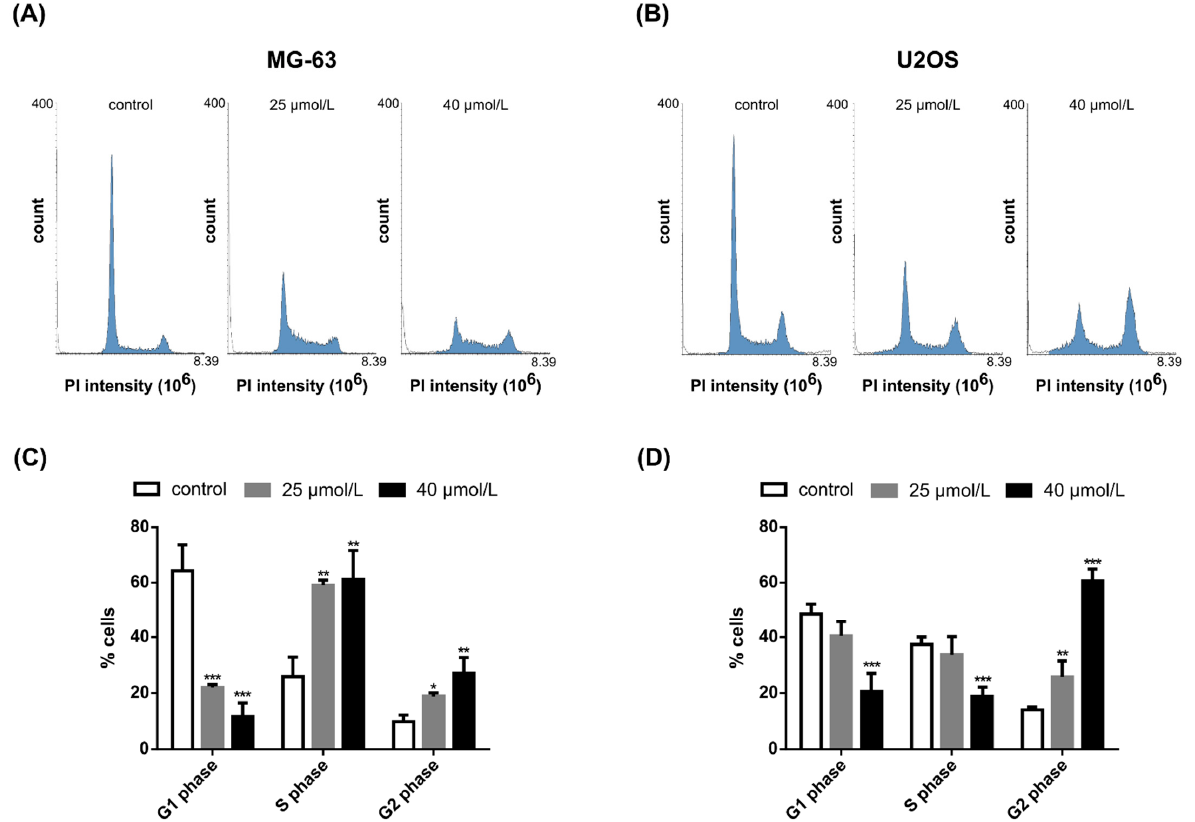
Figure 3. Effects of DiOHF on cell cycle distribution. MG-63 and U2OS cells were stained with propidium iodide and the cell cycle was analyzed by flow cytometry. Histograms representative of cell cycle distribution of ( A ) MG-63 and ( B ) U2OS cells. Cell cycle distribution (%) in ( C ) MG-63 and ( D ) U2OS cells. The data are mean ± SD ( n = 3). Significant differences (asterisks) are shown relative to 0.1% DMSO control; * p < 0.05, ** p < 0.01, *** p < 0.001 (one-way ANOVA).